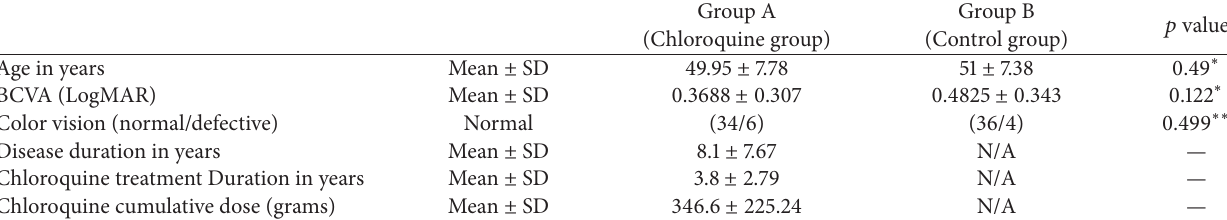
Table 1: Demographic and examination data of both groups.